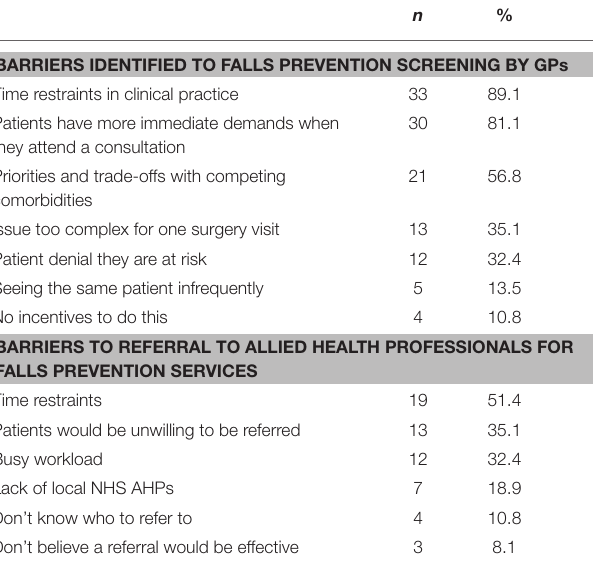
TABLE 4 | Barriers to falls prevention for GPs ( n =